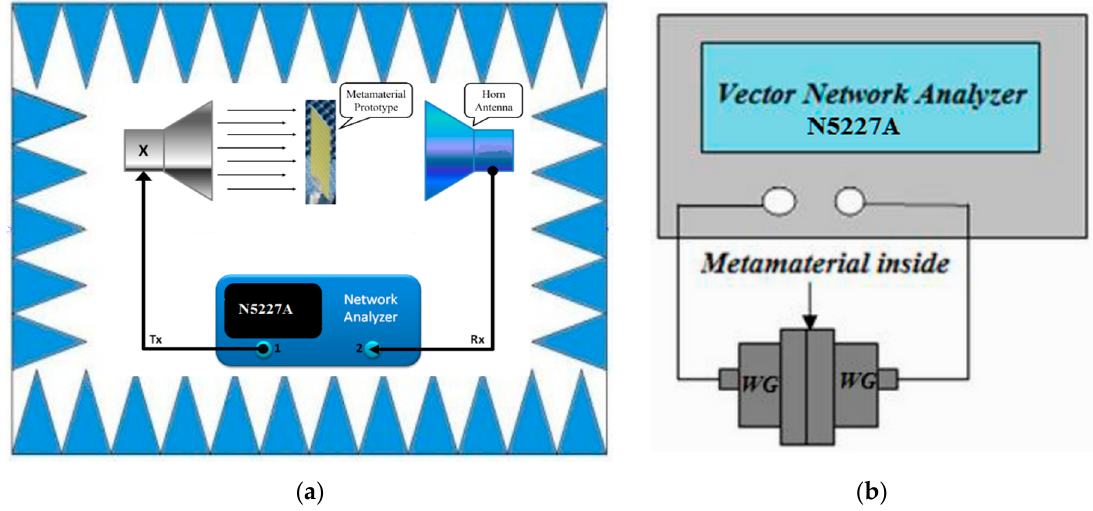
Figure 5. Experimental setup for measuring the S 11 and S 21 parameters: ( a ) horn antenna method; ( b ) waveguide (WG) method. ( b ) waveguide (WG)